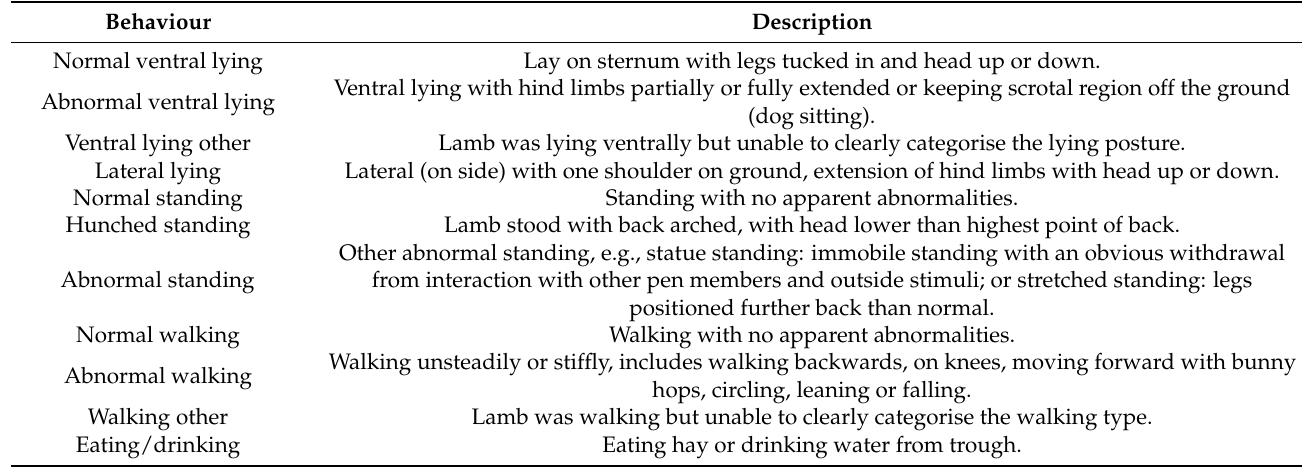
Table 2. Ethogram used for behavioural observations for lambs after castration. Behaviour Description Normal ventral lying Lay on sternum with legs tucked in and head up or down. Ventral lying with hind limbs partially or fully extended or keeping scrotal region off the ground Abnormal ventral lying (dog sitting). Ventral lying other Lamb was lying ventrally but unable to clearly categorise the lying posture. Lateral lying Lateral (on side) with one shoulder on ground, extension of hind limbs with head up or down. Normal standing Standing with no apparent abnormalities. Hunched standing Lamb stood with back arched, with head lower than highest point of back. Other abnormal standing, e.g., statue standing: immobile standing with an obvious withdrawal Abnormal standing from interaction with other pen members and outside stimuli; or stretched standing: legs positioned further back than normal. Normal walking Walking with no apparent abnormalities. Walking unsteadily or stiffly, includes walking backwards, on knees, moving forward with bunny Abnormal walking hops, circling, leaning or falling. Walking other Lamb was walking but unable to clearly categorise the walking type. Eating/drinking Eating hay or drinking water from